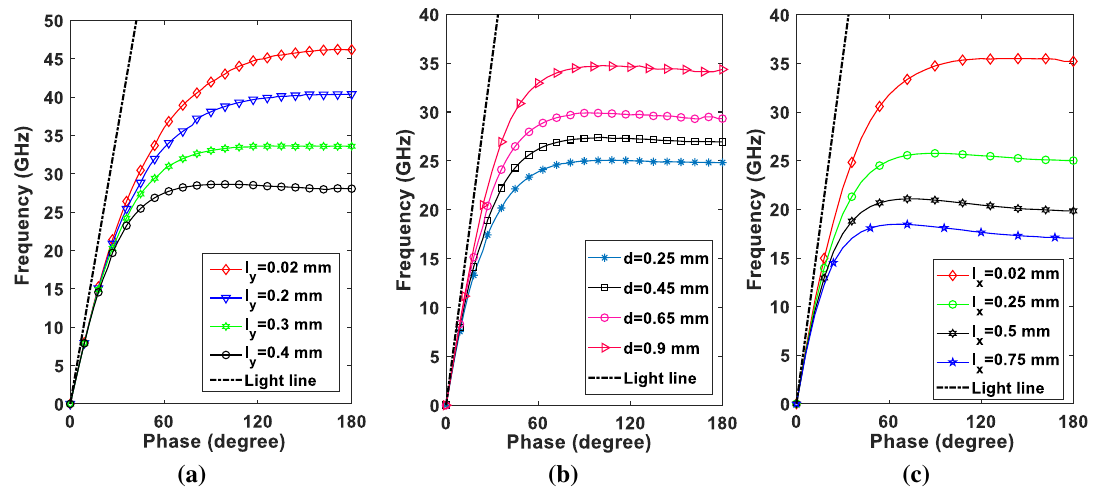
Figure 2. Dispersion diagrams showing the effect of geometrical parameters variation. ( a ) Varying l y by keeping W = 2.43 , l x = 0.5, p = 0.7, d = 0.54 , and l y + g = 0.48 . ( b ) Varying d by keeping W = 2.34, l x = 0.5, p = 0.7, l y = 0.43 , and g = 0.05 . ( c ) Varying l x by keeping , W − l x = 0.4, l y = 0.43, p = 0.7, d = 0.54, g = 0.05 (all dimensions are in mm). CST microwave studio 2020